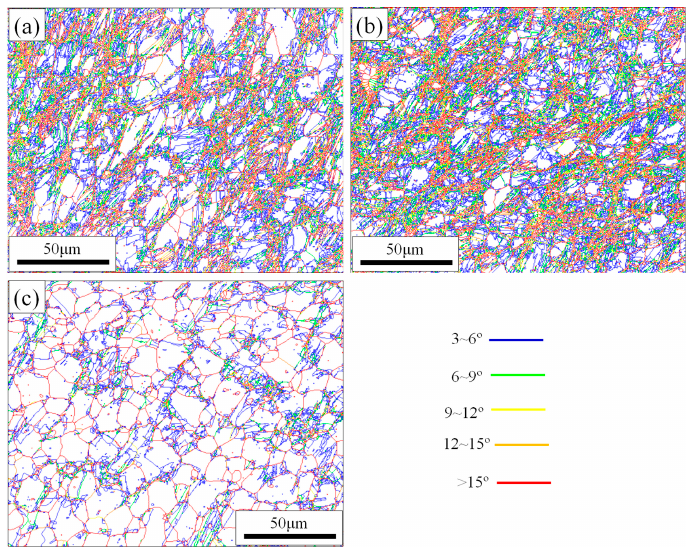
Figure 5. Distributions of kernel average misorientation (KAM) in the NiTiFe SMA subjected to ECAE at various temperatures: ( a ) 400 °C; ( b ) 450 °C; ( c ) 500 °C.